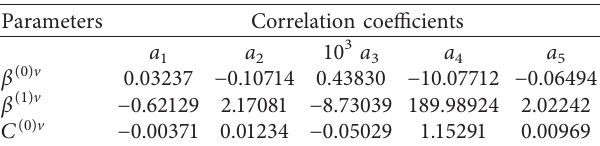
Table 7: The temperature-dependence correlation coefficients of Pitzer parameters of YCl 3